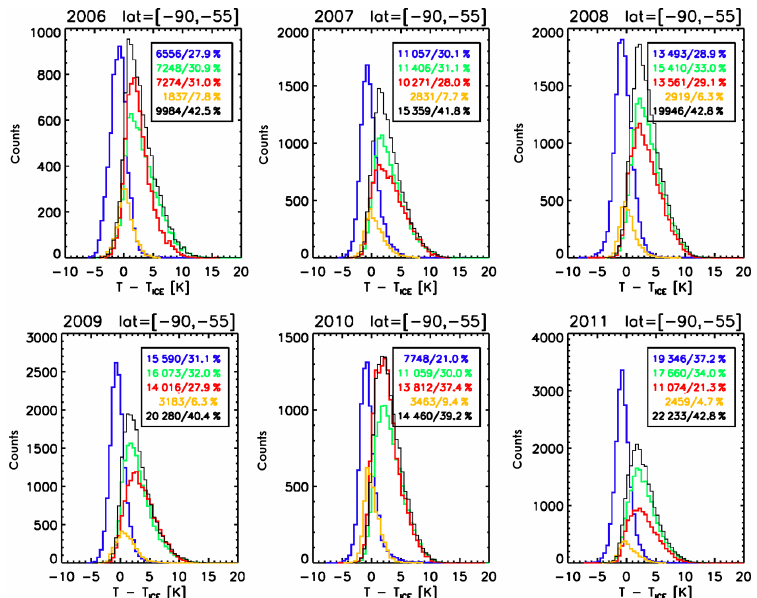
Figure 3. The 6 years of southern polar winter PSC class frequency distributions as a function of T − T ICE . For consideration of the dehydra- tion process in the polar vortex over the winter, coincident temperatures from ERA-Interim reanalyses and zonal mean water vapour mixing ratios on equivalent latitudes of the Microwave Limb Sounder (MLS) instrument (e.g. Lambert et al., 2012) are used for the computation of T ICE (Marti and Mauersberger, 1993). The years 2006–2011 are presented for the four main PSC classes ice (blue), NAT (green), STS (red), and NAT_STS (orange), as well as a former NAT classification method (black) based on Spang and Remedios (2003); for details, see the text. Please note the changing maximum counts of observation and corresponding maximum value of the y axis for individual winters. The coloured numbers in the legend indicate the total number of the corresponding cloud types and the partition on the total number of PSC observations in